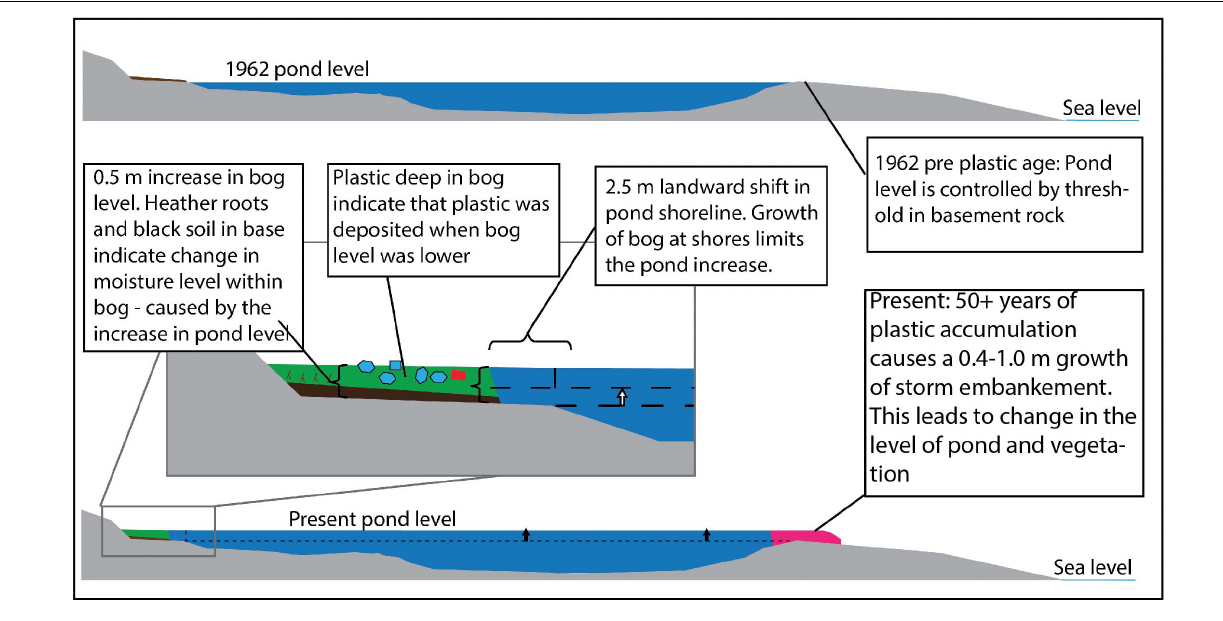
Frontiers in Marine Science |